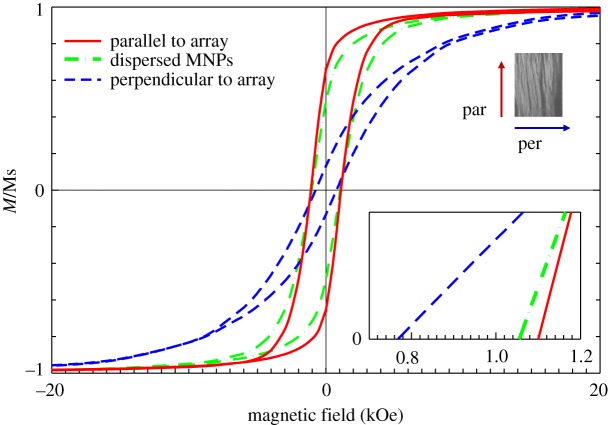
Magnetic characterization of dispersed core–shell α″-Fe16N2 /Al2O3 MNPs and their assembled array under an EMF of 15 T with the measured magnetic field applied parallel and perpendicular to arrays.